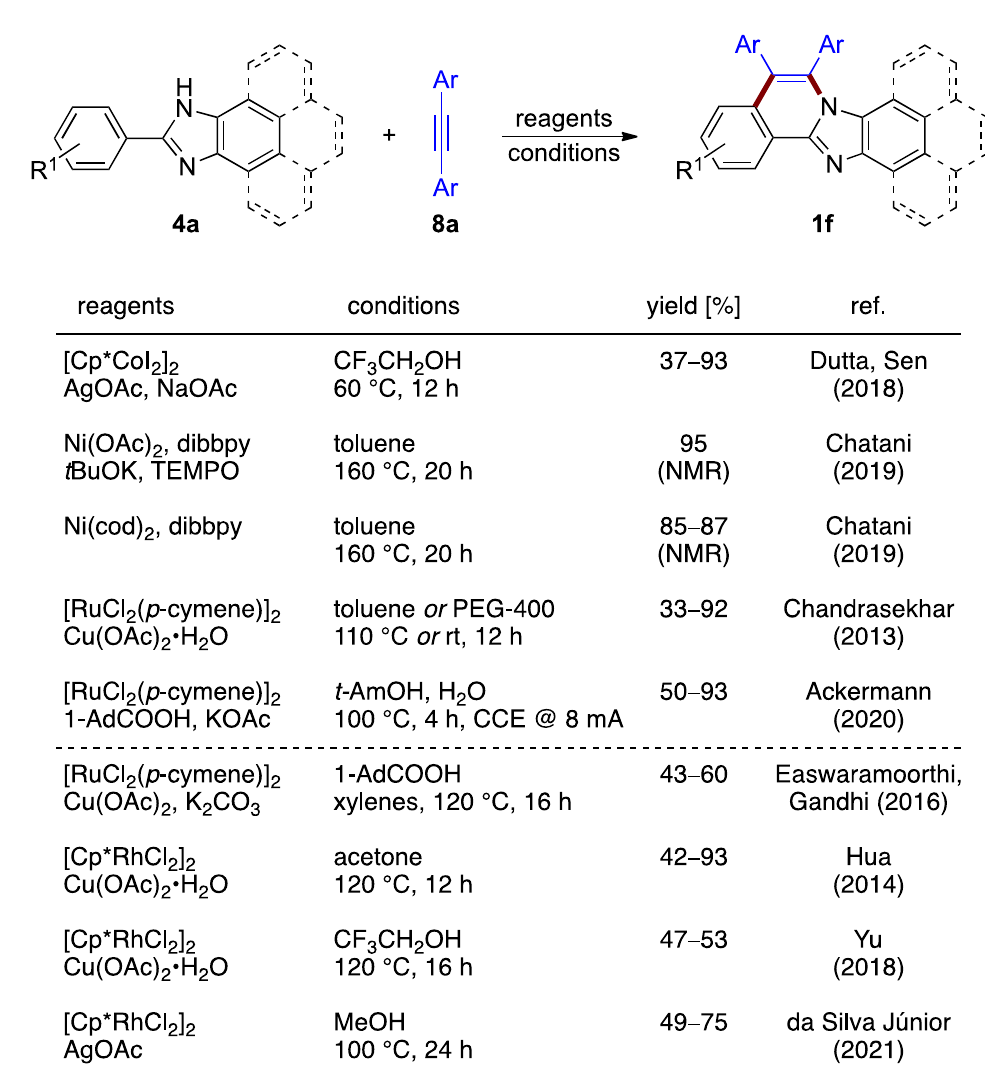
Figure 7. Oxidative annulation of 2-phenylbenzimidazoles 4a and their fused homologs with internal alkynes 8 by different protocols [12–19].